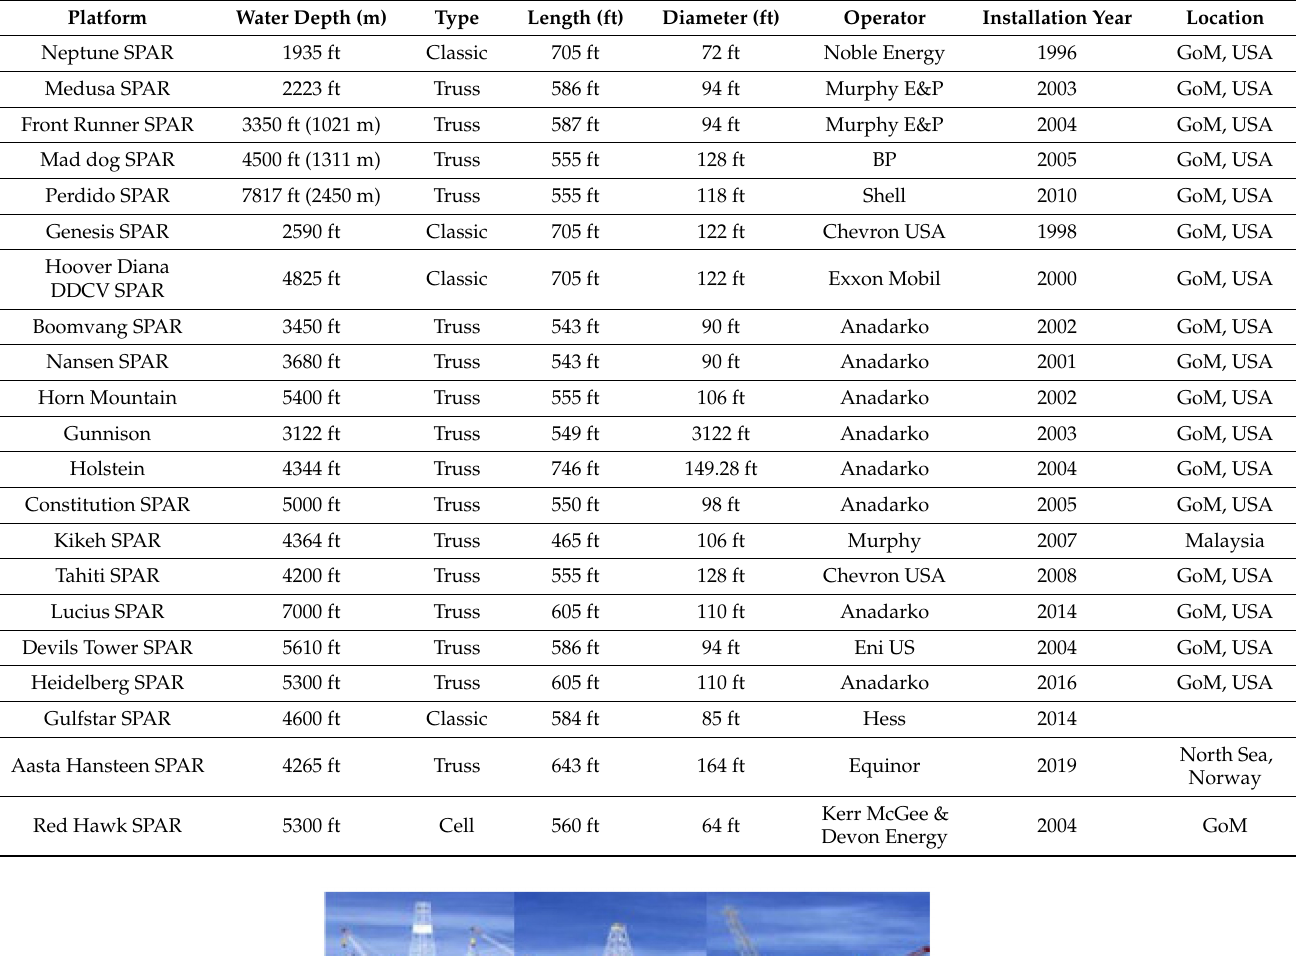
Table 6. List of some SPAR platforms constructed.